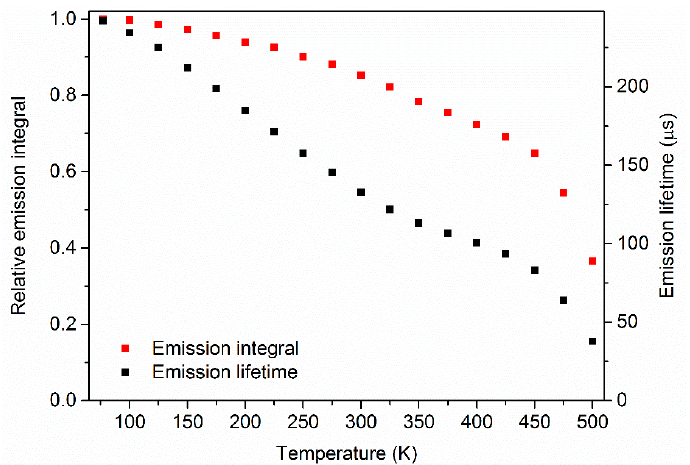
Figure 12. Emission integrals of U 6+ excited at 338 nm, and averaged decay lifetimes monitoring the 550 nm emission of Gd 3 Li 3 (Te 0.99 U 0.01 ) 2 O 12 .